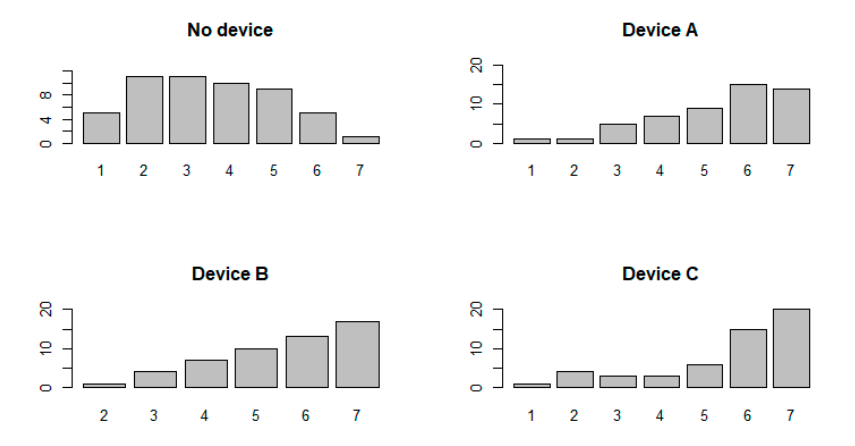
Figure 17. Distribution of the number of answers to each level in the Likert scale for the question about the easiness of door opening with no device or with devices A, B or C.